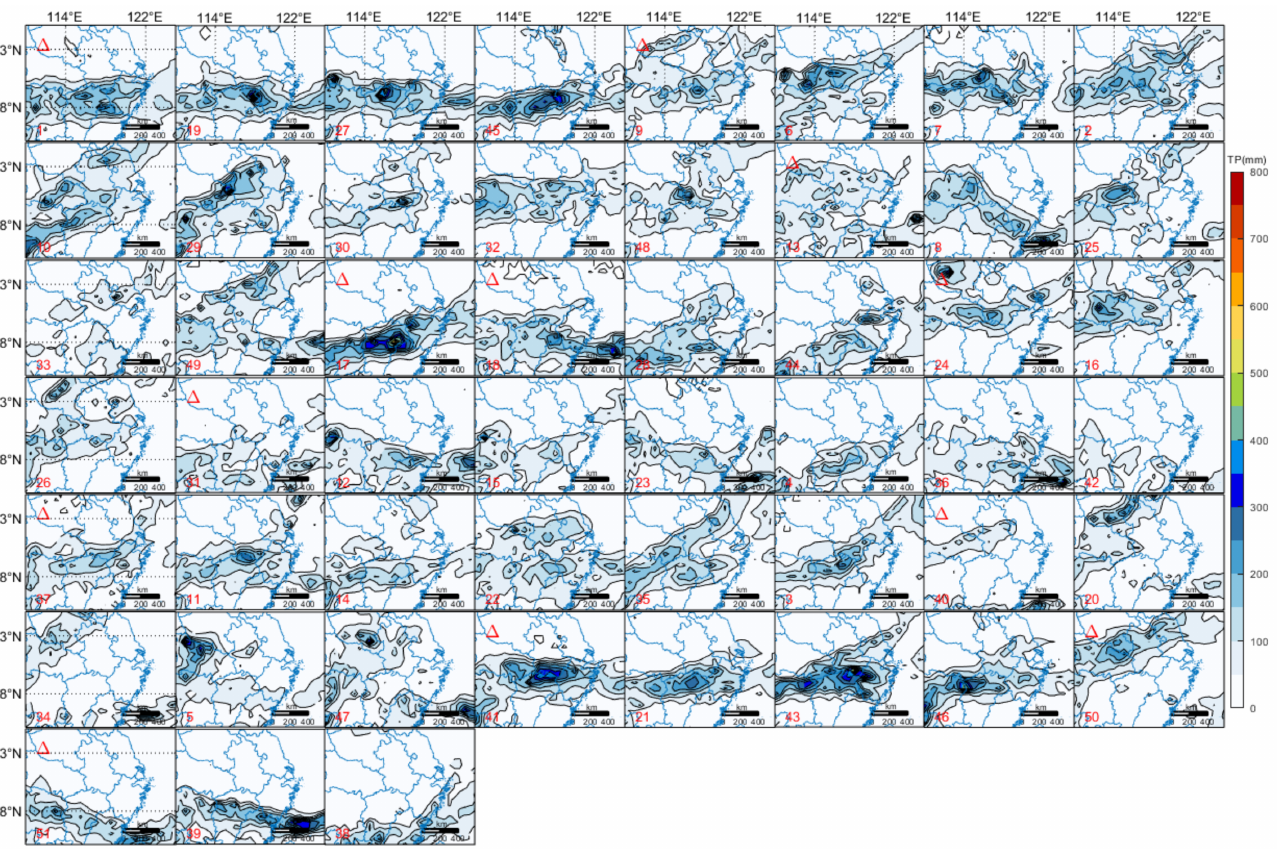
Figure 3. EOF_AP clustering results of the accumulated rainfall from 29 June to 2 July forecasted by the ECMWF ensemble model with the start time at 12:00 on 22 June. (cid:52) indicates the member of the clustering center, and the left subscript number indicates the index in original ensemble